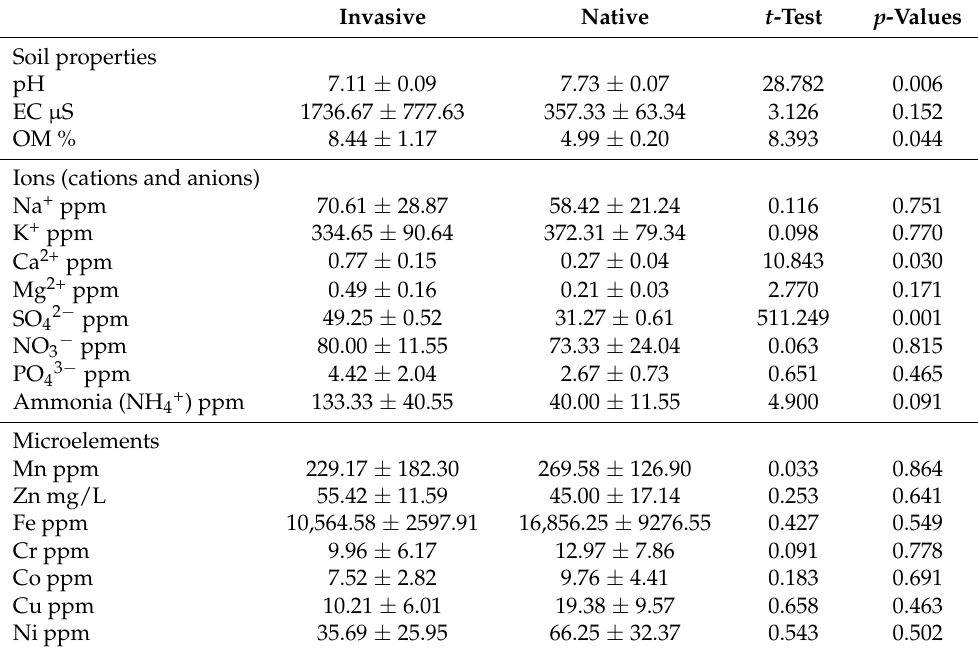
Data represented as means ± SE, n = 6. Table 2. Soil properties, ion concentrations, and microelement concentrations of soils in stands invaded by Ipomoea carnea and adjacent stands with native vegetation in southwest Saudi